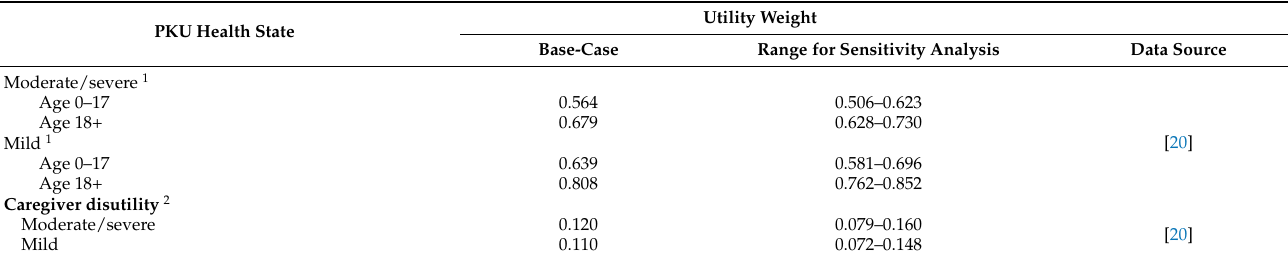
Table 3. Quality of Life